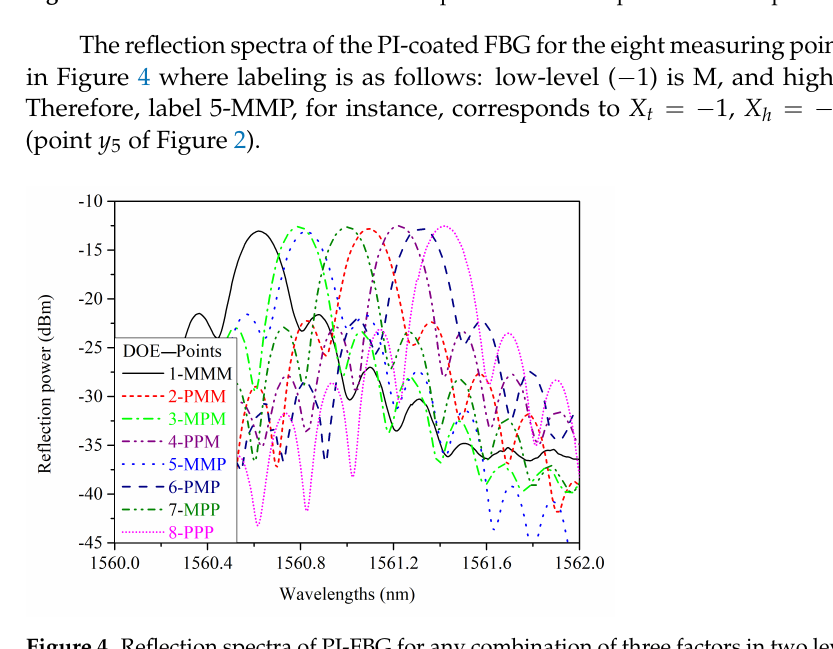
Figure 3. The resolution of the reflection spectrum in our experimental setup is around 5pm.